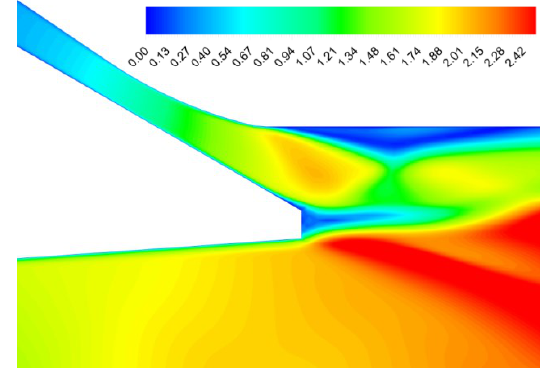
Fig. 19. Contours of Mach number – detail of supersonic secondary